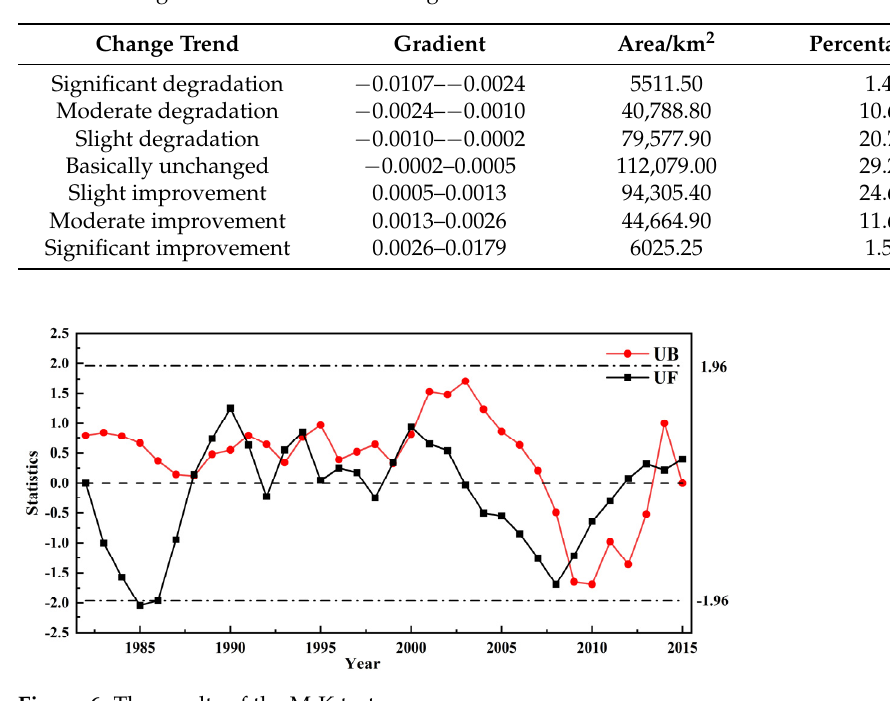
Figure 5. Distribution of the NDVI change trend during 1982–2015. Table 4. Change trend of the NDVI during 1982–2015.